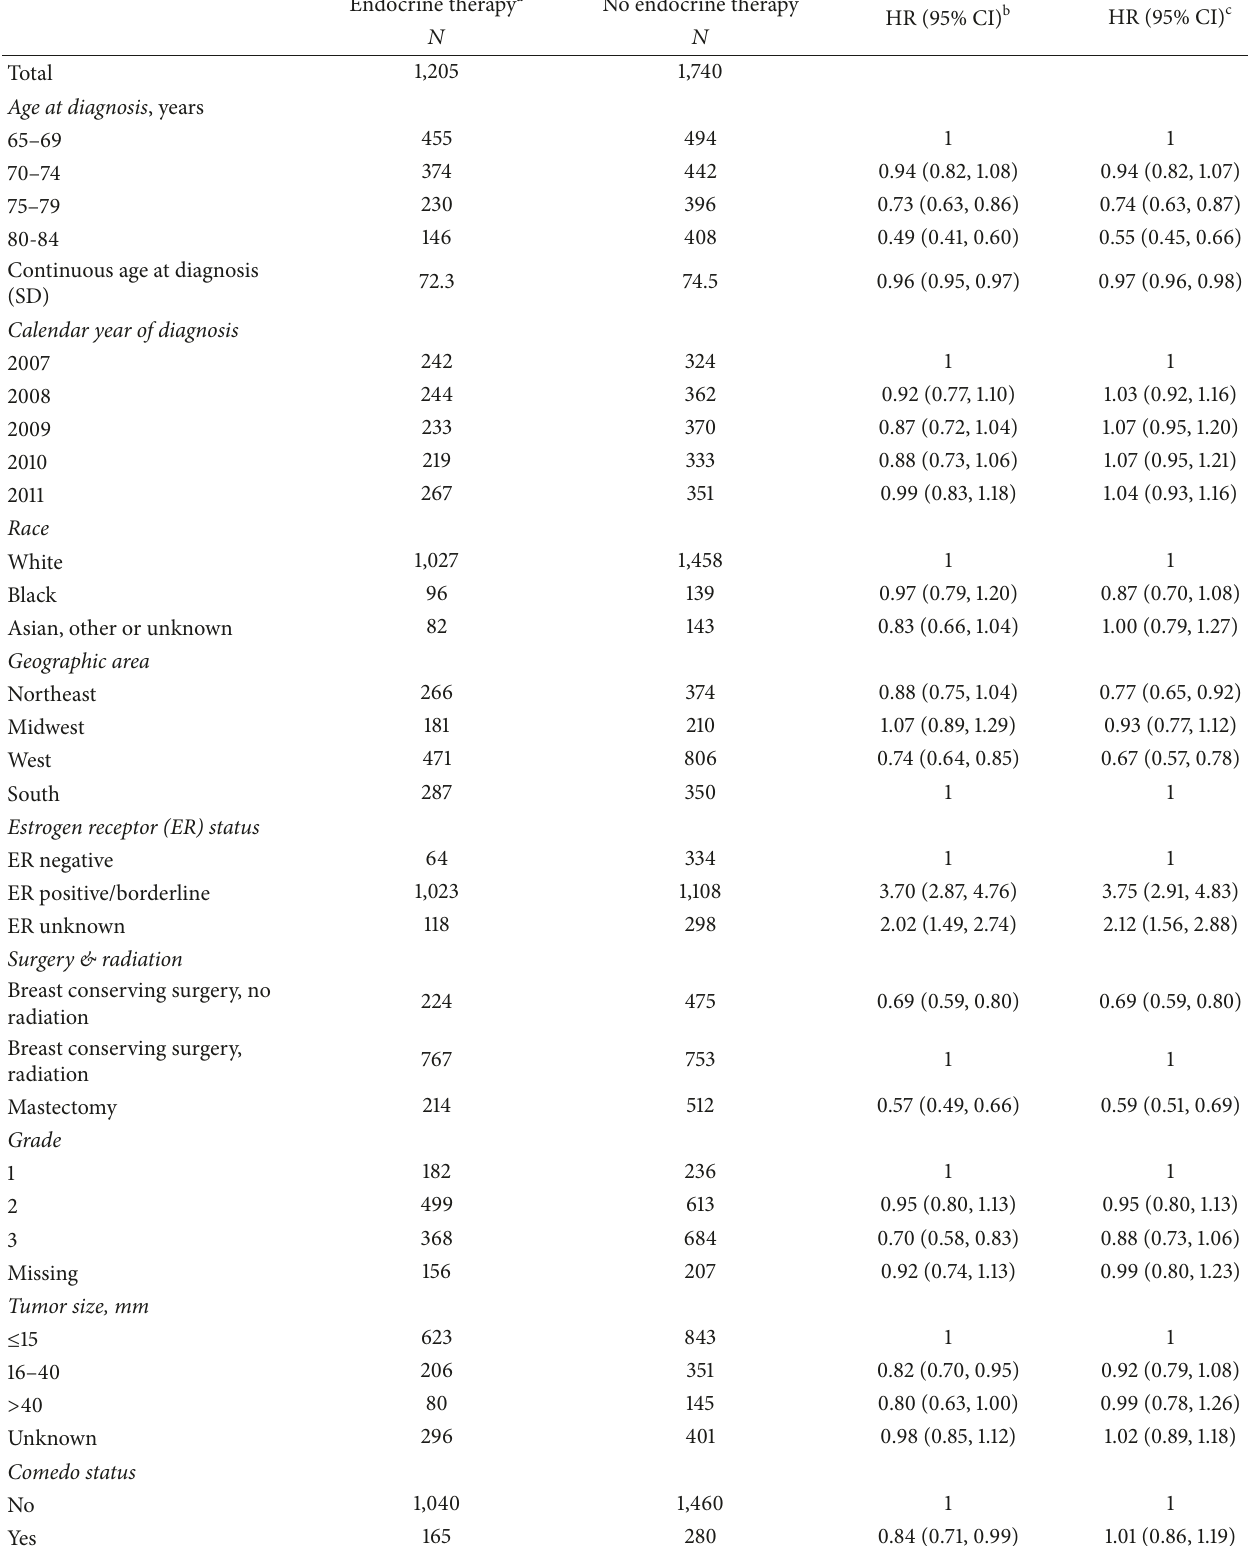
Table 1: Characteristics among women with a DCIS diagnosis in relation to use of endocrine therapy, SEER-Medicare,